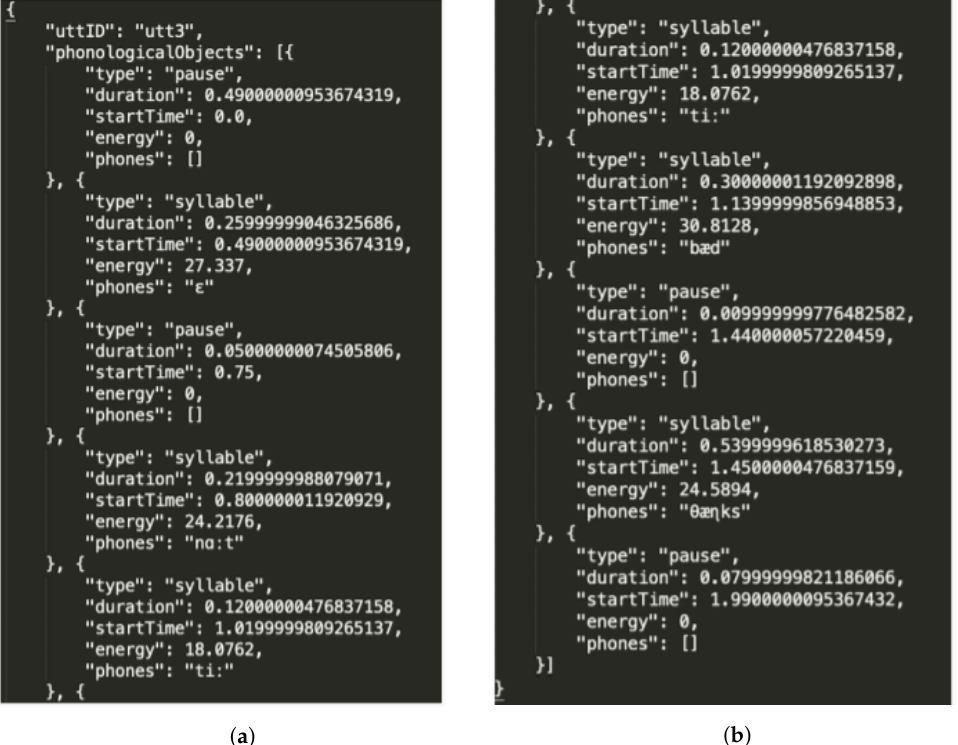
Figure 3. .ctm file for task1 in lesson 1 “Yeah, not too bad, thanks!”. The syllabic partition for “Yeah, not too...” is shown in ( a ) and the rest of the phrase, “... bad, thanks”, is presented in ( b ).